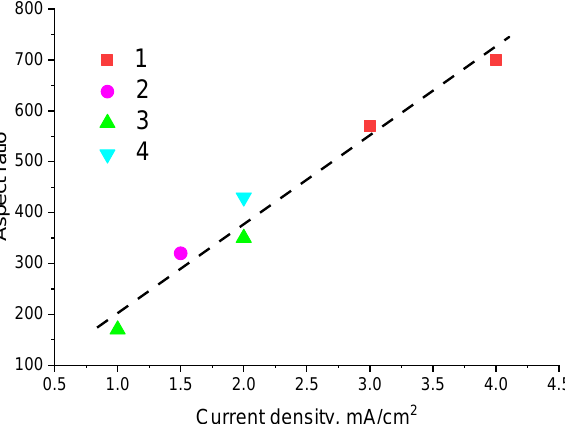
Figure 4. The dependence of the aspect ratio of the Ni NWs on the electrodeposition current density for different values of the MPAA thickness: 1—55 µ m (Sample No. 5 and 6, type II); 2—65 µ m (Sample No. 2, type I); 3—65 µ m (Sample No. 1 and 3, type I); 4—75 µ m (Sample No. 4, type II).